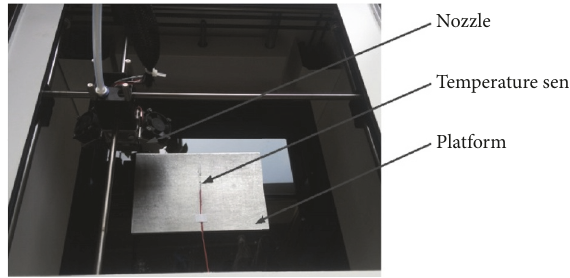
Figure 10: The temperature-measuring device.